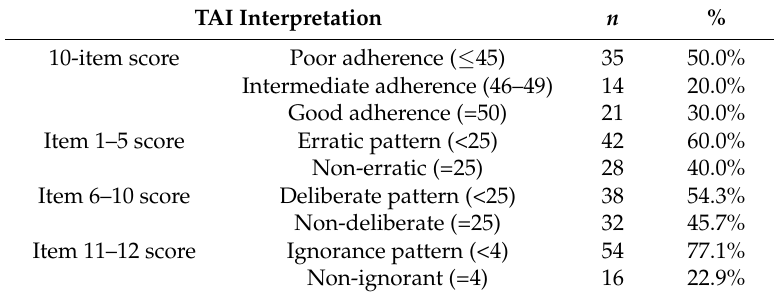
Table 3. Level of adherence and pattern of non-adherence.